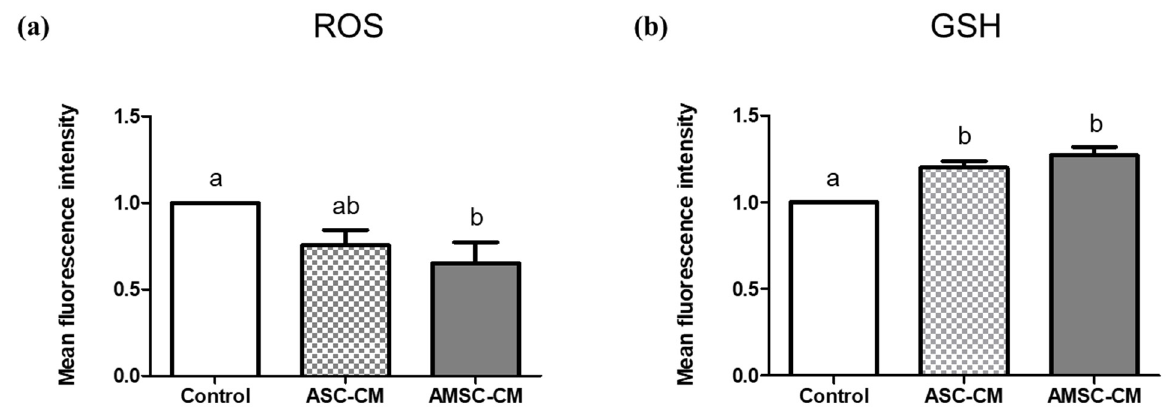
Figure 3. Evaluation of intracellular reactive oxygen species (ROS) and glutathione (GSH) in blastocysts (BL) cultured with human adipose-derived mesenchymal stem cell conditioned medium (ASC-CM) and amniotic membrane-derived mesenchymal stem cell conditioned medium (AMSC-CM). ( a ) ROS and ( b ) GSH level in BL. Data are presented as the mean ± SEM. Superscript letters in each column indicate significant differences ( p < 0.05).